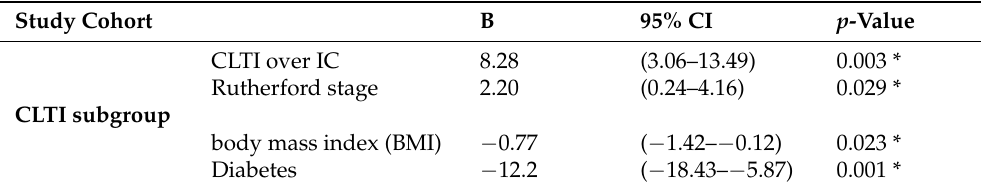
Table 4. Significant predictor variables from univariate linear regression analyses for the total sum score of the modified runoff resistance (mROR) score for the study cohort of 40 patients and the subgroup of 20 patients with chronic limb-threatening ischemia (CLTI). All epidemiologic parameters from Table 1 were tested for their predictive values to mROR. In the subgroup of intermittent claudication (IC), no significant predictor variable was found. The coefficient for the continuous variables Rutherford stage and body mass index refer to a change of one unit. A negative value signifies a reverse correlation. An asterisk * marks a p -value < 0.05. B: regression coefficient B; CI: confidence